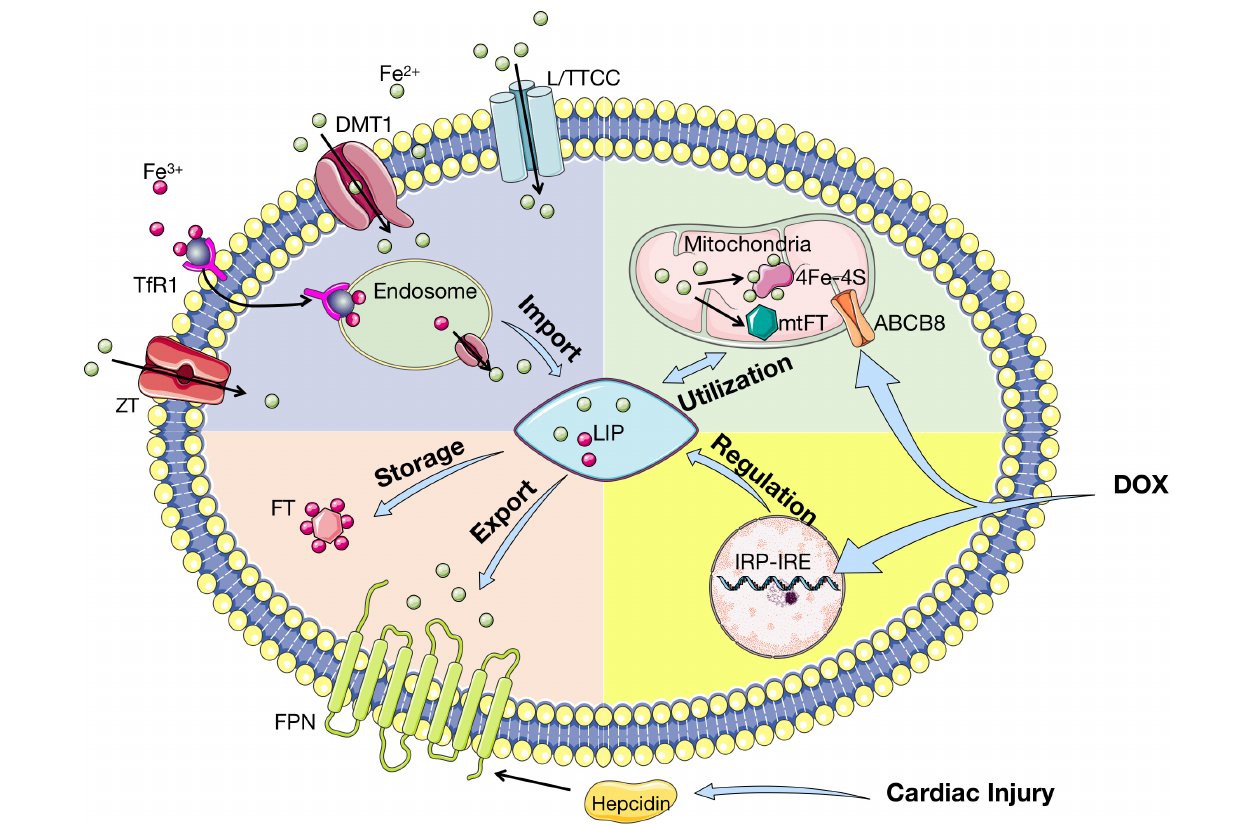
FIGURE 4 | Iron homeostasis in cardiomyocytes. Tf-bound iron is imported into cardiomyocytes via TfR1, whereas Non-Tf-bound iron enters via DMT1, L/TTCC, and ZT. After imported into cardiomyocytes, iron is located in endosome and deoxidated before stored in LIP. In cytoplasm, iron is stored by binding to FT and exported by FPN, which is regulated by hepcidin. Iron is transported into mitochondria for synthesis into 4Fe–4S and mtFT, which stores excessive iron during cardiac injury. ABCB8 is the iron exporter of mitochondria. Cardiac iron homeostasis is regulated by IRP-IRE with upregulation of TfR1 and downregulation of FT and FPN. Cardiac injury affects iron homeostasis by upregulating hepcidin, while DOX influences IRP-IRE and ABCB8. Tf, transferrin; TfR1: transferrin receptor 1; DMT1, divalent metal transporter 1; L/TTCC, L/T-type calcium channel; ZT, Zinc transporter; LIP, labile iron pool; FT, ferritin; FPN, ferroportin; Fe–S, iron–sulfur cluster; mtFT, mitochondrial ferritin; ABCB8, adenosine triphosphate (ATP)-binding cassette subfamily B member 8; IRP, iron regulatory protein; IRE, iron responsive elements; DOX,